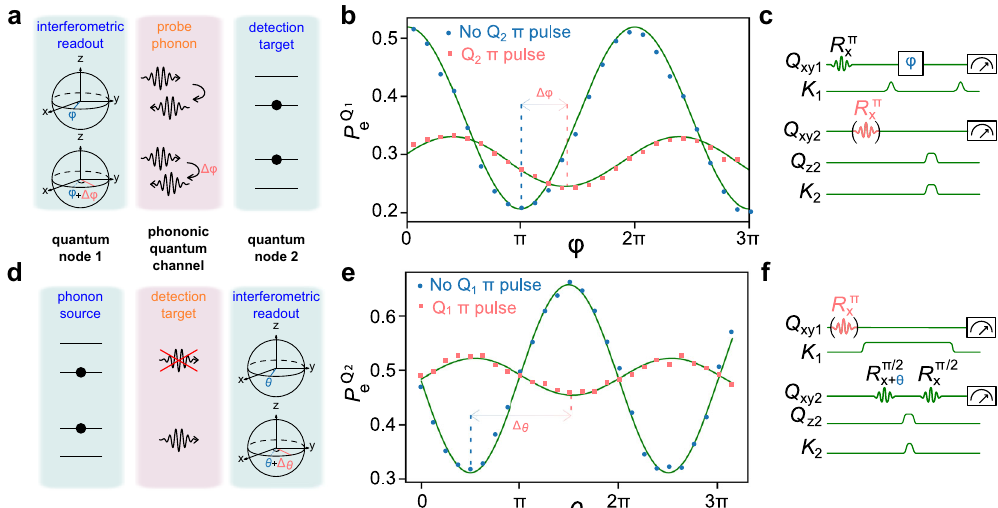
Fig. 4 Phonon interferomeric probe. Dispersive state-dependent interferometric probe. a Schematic roles played by each element. b Blue (salmon) points show the φ dependence of Q 1 ’ s fi nal P e when Q 2 is in g j i ( e j i ), showing a dependence of the phonon phase on Q 2 ’ s state, with a shift of ~0.4 π rad. c Qubit pulse sequences (see text for details). d Schematic roles played by each element for the dispersive phase- dependent interferometric probe. e Ramsey interference in Q 2 (blue circles) reveals Q 2 ’ s dependence on the relative phase with the phonon. When repeating the same protocol with no initial π pulse on Q 1 , we measure the Ramsey interference of Q 2 (salmon squares), shifted by π compared to the fi rst measurement. f Qubit pulse sequences, similar to c except Q 2 is always placed in ð g j i þ e i θ e j iÞ = is and the θ -dependent P Q 2 e